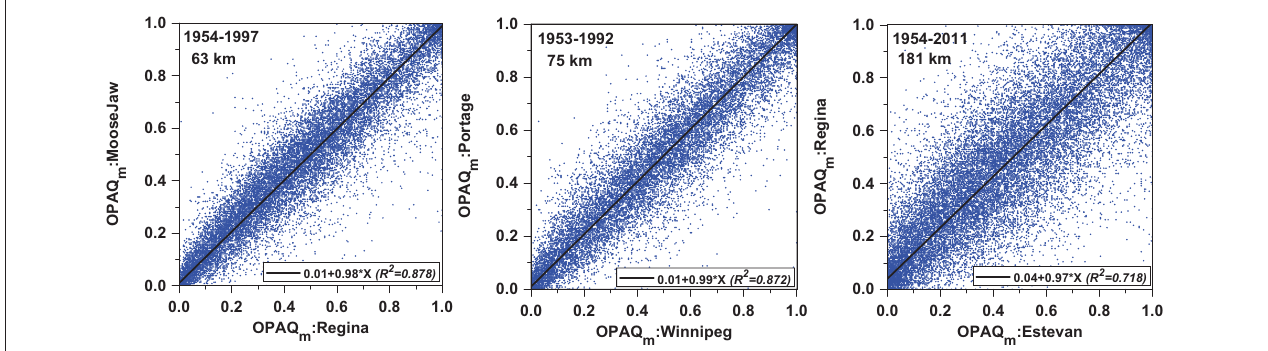
FIGURE 2 | Comparison of daily mean opaque cloud cover for Moose Jaw and Regina for 1954–1997 (left); (center) Portage-Southport and Winnipeg for 1953–1992, and (right) Regina and Estevan for 1954–2011.